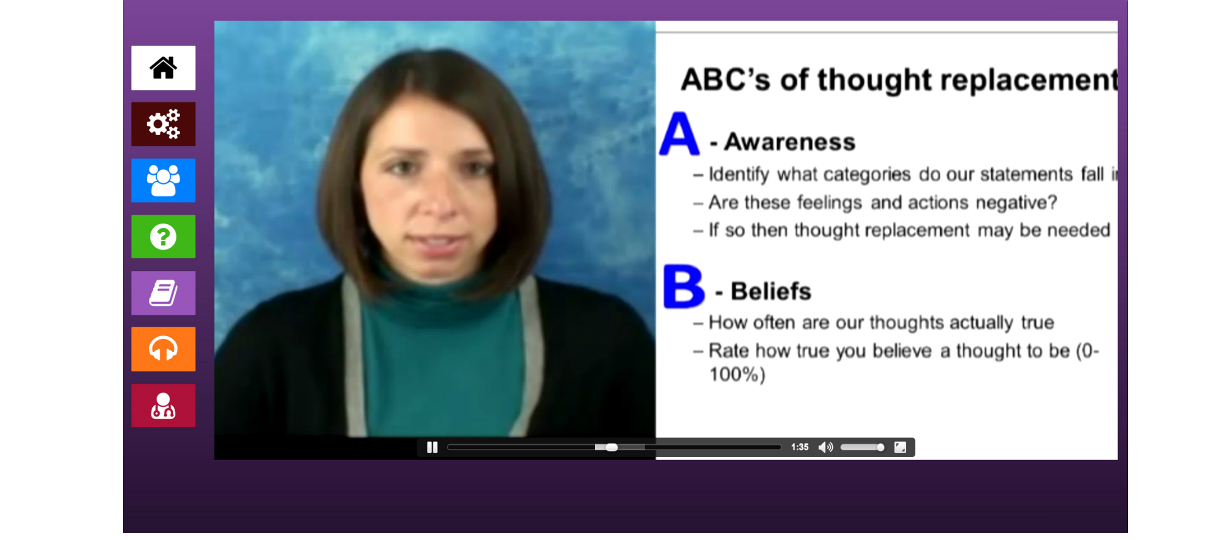
Figure 3. Patient-facing intervention constructed using content authorship and management